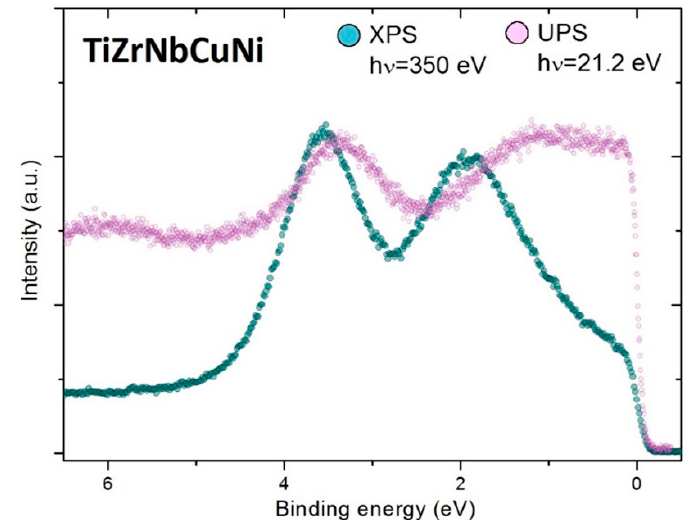
Figure 2. UPS and XPS spectra of TiZrNbCuNi alloy.